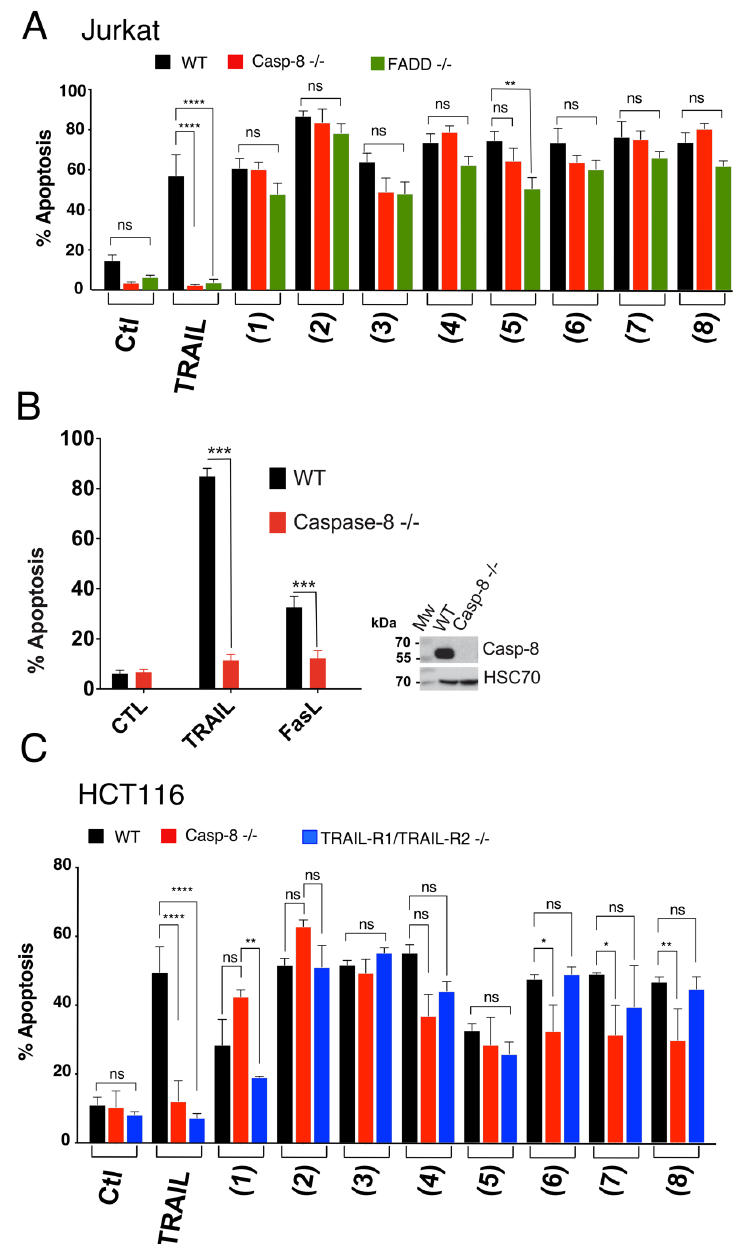
Figure 3. Monitoring apoptosis induced by marine compounds using flow cytometry in Jurkat and HCT116 cells. ( A ) Jurkat WT, Cas-8- / - and FADD- / - cells were treated with the indicated compounds for 24 h then stained with 7AAD and Annexin V and fluorescence was analyzed by flow cytometry. ( B ) Flow cytometry and Western blot analysis to determine the sensitivity of HCT116-Cas8- / - toward TRAIL-and FasL-induced cell death. Cells were treated with and without TRAIL and FasL for 6 h then subjected to dual staining as above and apoptotic percentage was determined by flow cytometry. For Western blot, cell lysates were prepared and loaded on SDS-PAGE (12%) followed by immunoblotting using the corresponding antibodies. HSC70 was used as loading control. ( C ) Colon HCT116 (WT, Cas8- / -, and TRAIL-R1 / TRAIL-R2- / -) cancer cell lines were treated as previously mentioned. All values are presented here as ± SD (n = 3). Significance was evaluated by two-way ANOVA. * p < 0.05, ** p < 0.01, *** p < 0.001 and **** p <